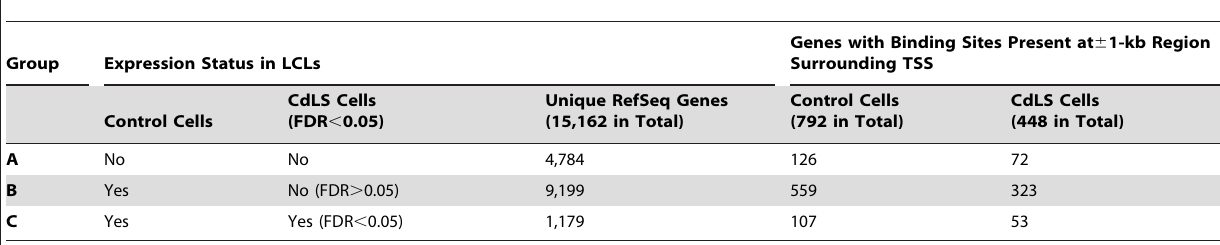
Table 1. Cohesin associated to the + / 2 1-kb vicinities of TSSs among three different groups of genes in control and CdLS LCLs.